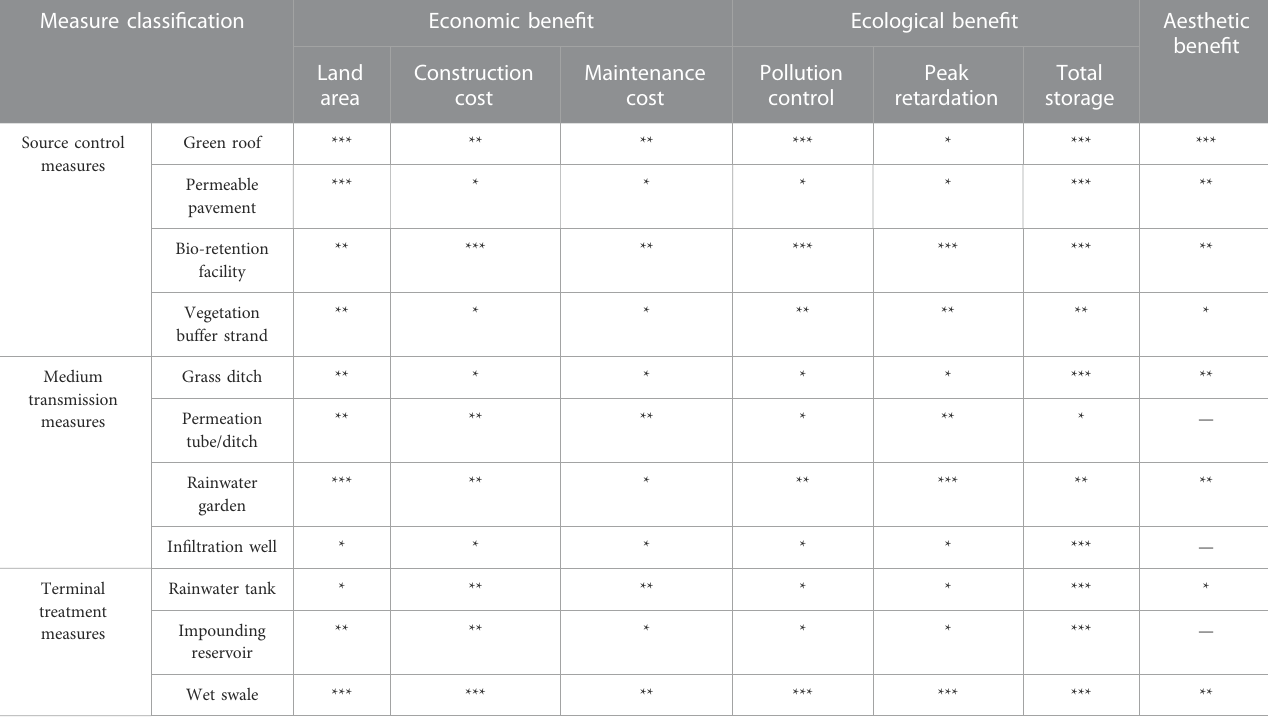
TABLE 4 Comparison of other bene fi ts of urban rainwater utilization measures. Measure classi fi